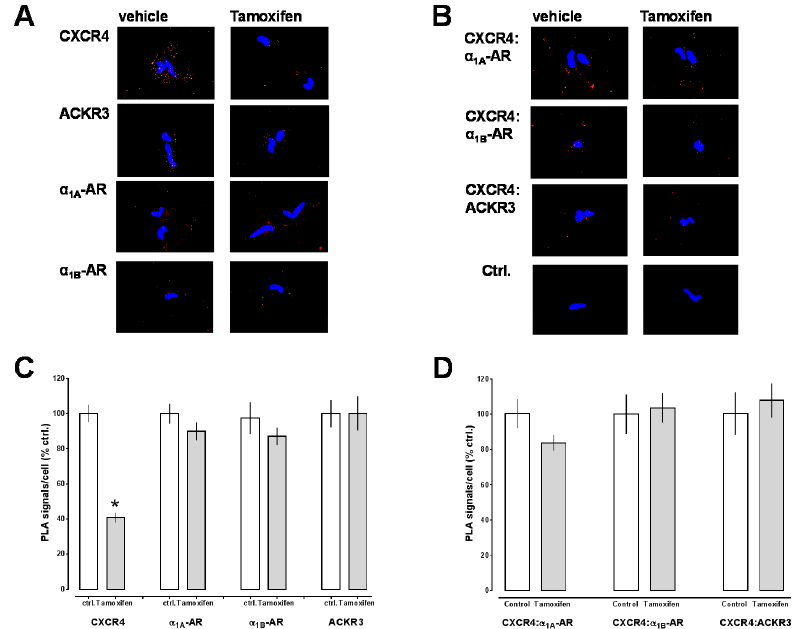
Figure 4. ( A , B ) Individual receptors ( A ) and interactions between CXCR4 and α 1A/B -AR and between CXCR4 and ACKR3 ( B ) were visualized by PLA in VSMC from transgenic mice after treatment with vehicle (left) or tamoxifen (right). Images show merged PLA/DAPI signals. Ctrl.: Antibody control; the primary antibody was omitted; ( C , D ) Quantification of the number of PLA signals per cell for individual receptors ( C ) and receptor–receptor interactions ( D ) in VSMC from transgenic mice after treatment with vehicle (ctrl., open bars, n = 7) or tamoxifen (grey bars, n = 8). Data are expressed as % of vehicle treated animals. *: p < 0.05 vs. ctrl. (vehicle). A B